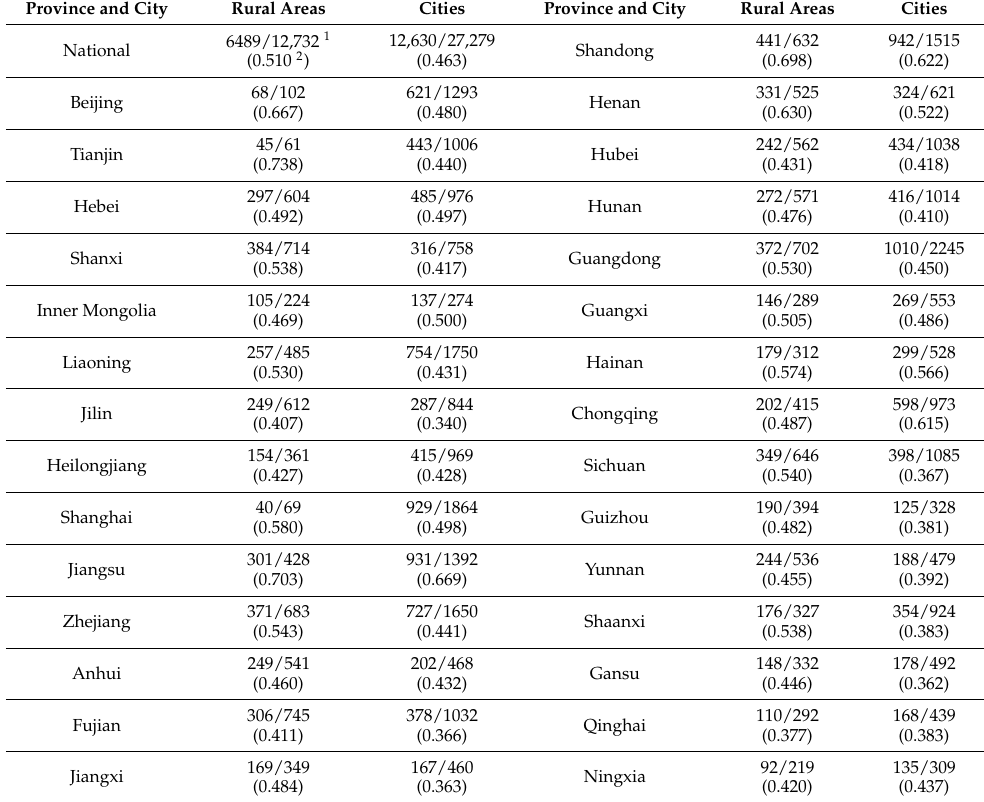
Table 5. Number and ratio of the rural and urban relative poverty population in provinces and cities of China (person, %).